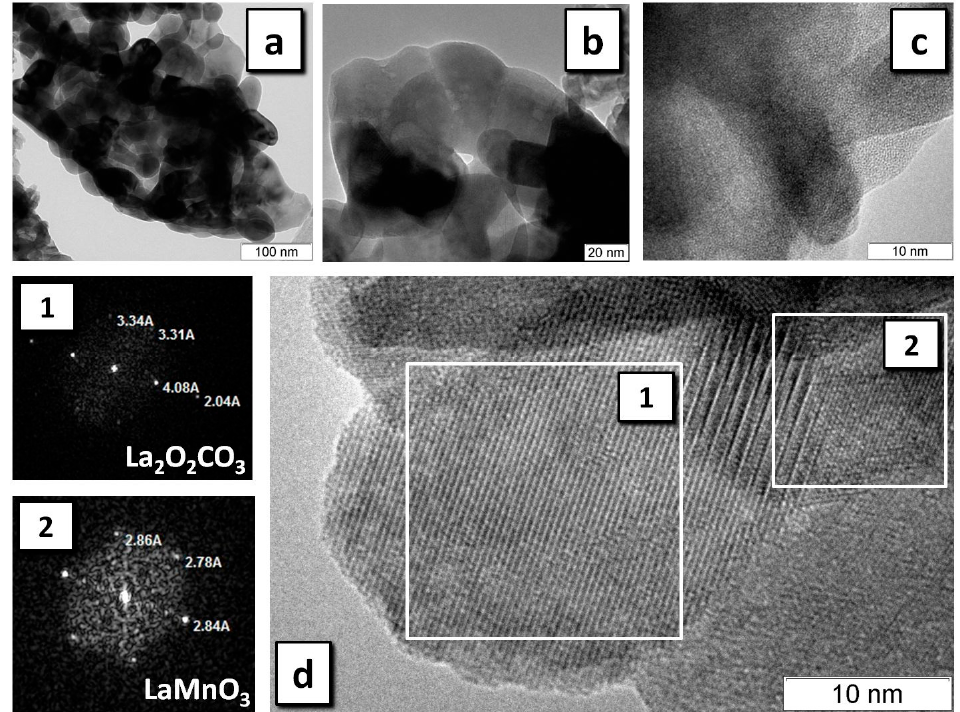
Figure 6. HRTEM of LaMnO 3 obtained in the SHS regime: LaMnO 3 phase with resolution of ( a ) 100 nm, ( b ) 20 nm; ( c ) amorphous phase; ( d ) the selected areas and their diffraction patterns (1), (2).